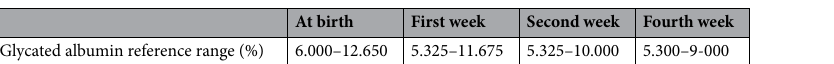
Table 4. Reference range for glycated albumin in preterm infants (serum glycated albumin (GA) levels are calculated as the percentage of GA relative to total albumin).